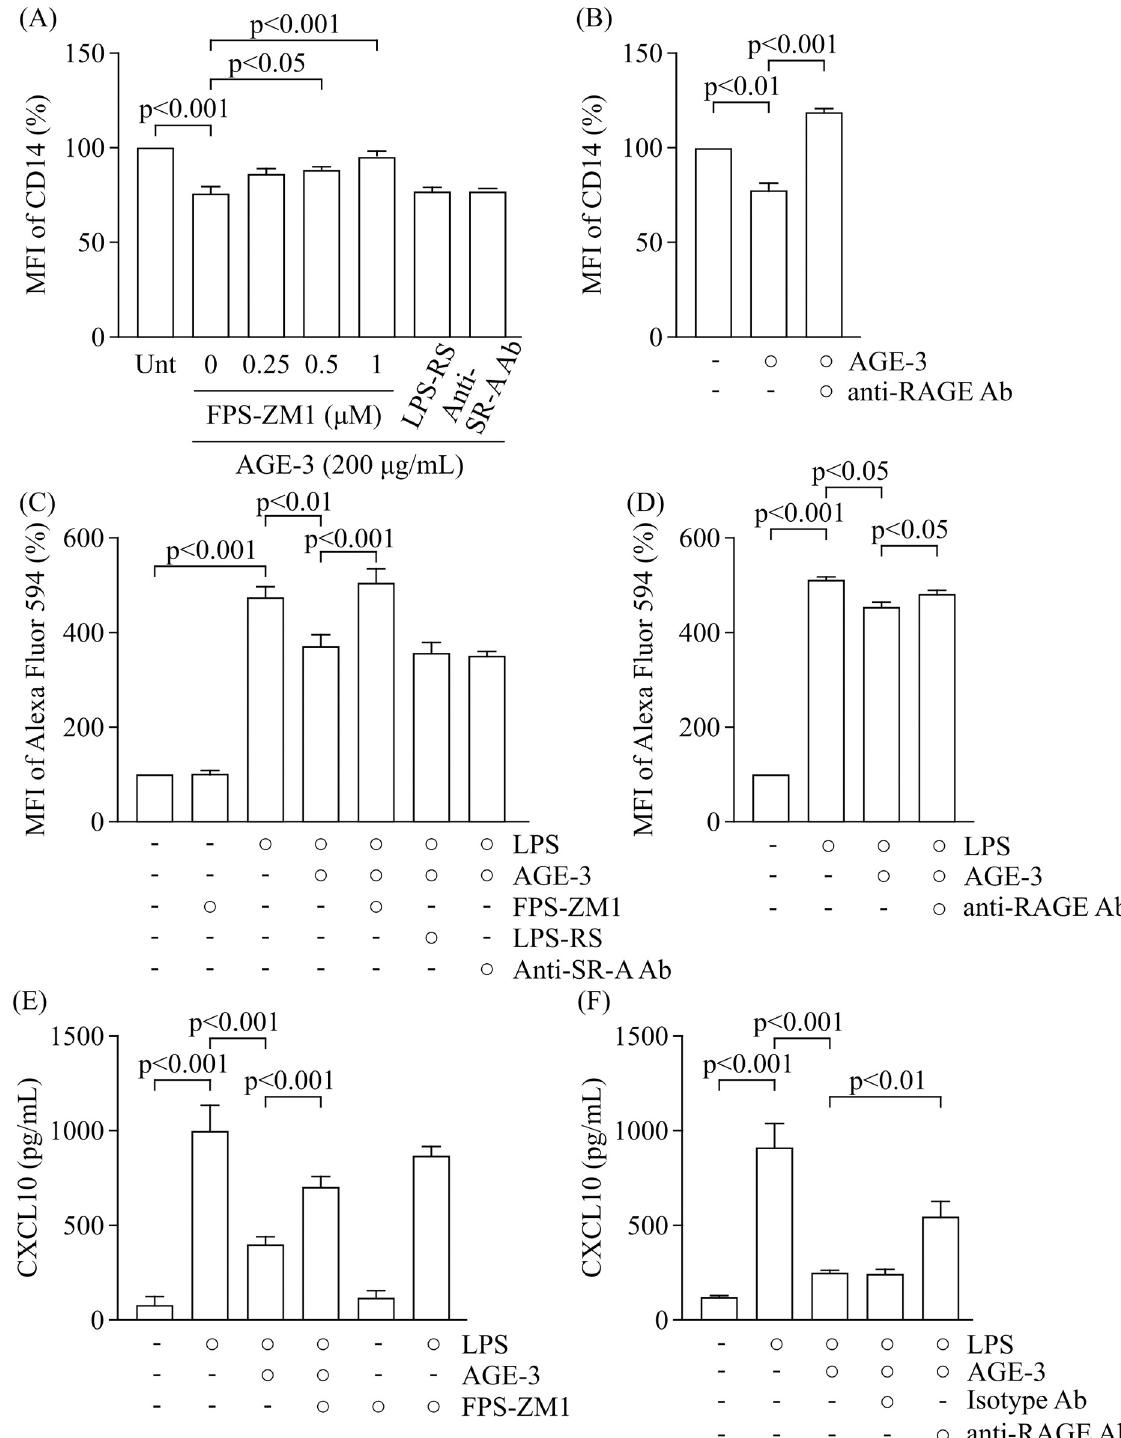
Fig 4. Involvement of RAGE on the inhibitory effect of AGE-3. (A) Effect of pharmacological inhibitors on the AGE-3-induced downregulation of CD14 expression (n = 3; AGE-3+LPS-RS and AGE-3+Anti-SR-A Ab, n = 6; Unt, AGE-3 and AGE-3+FPS-ZM1 at 0.25– 1.0 μ M, Tukey’s test). Cells were concomitantly treated with FPZ-ZM1 at 1 μ M or LPS-RS at 10 μ g/mL and AGE-3 at 200 μ g/mL for 4 h. (B) Effect of anti-RAGE neutralising antibody on the AGE-3-induced downregulation of CD14 expression (n = 3). Cells were pre-treated with anti-RAGE antibody at 20 μ g/mL for 1 h before incubation with AGE-3 for 4 h. (C) Effect of FPS-ZM1 on LPS uptake in RAW264.7 cells